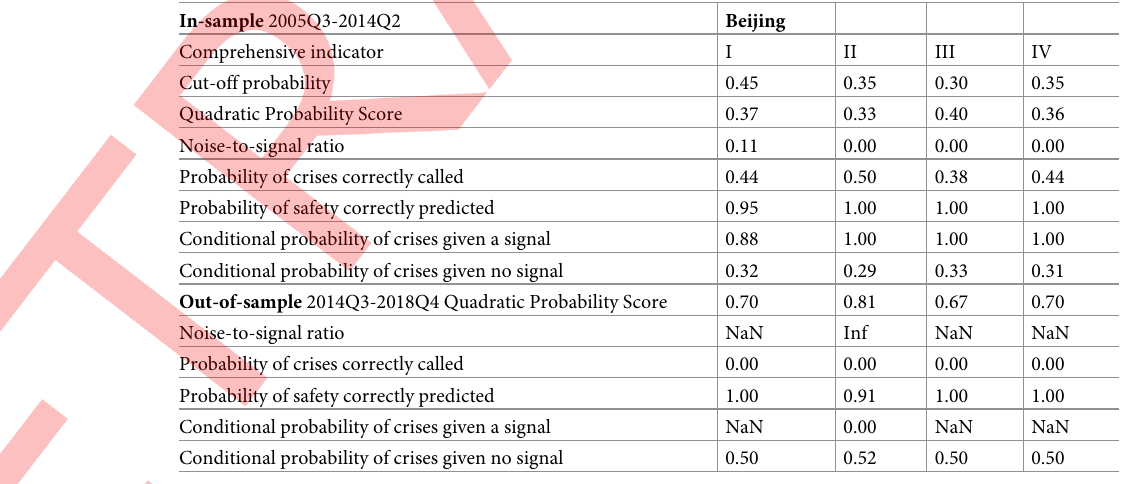
Table 5. Predictive ability from the comprehensive